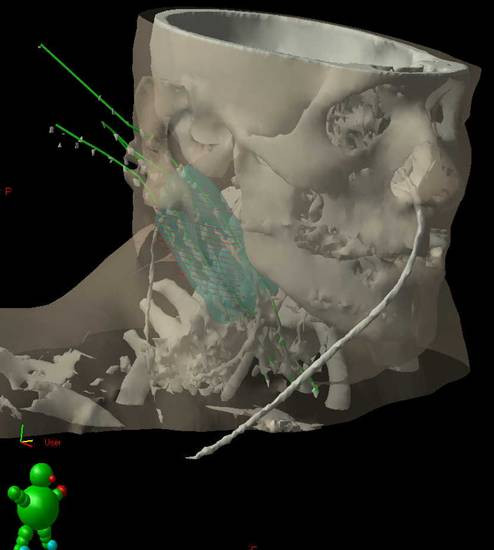
Three-dimensional planning CT image reconstruction.